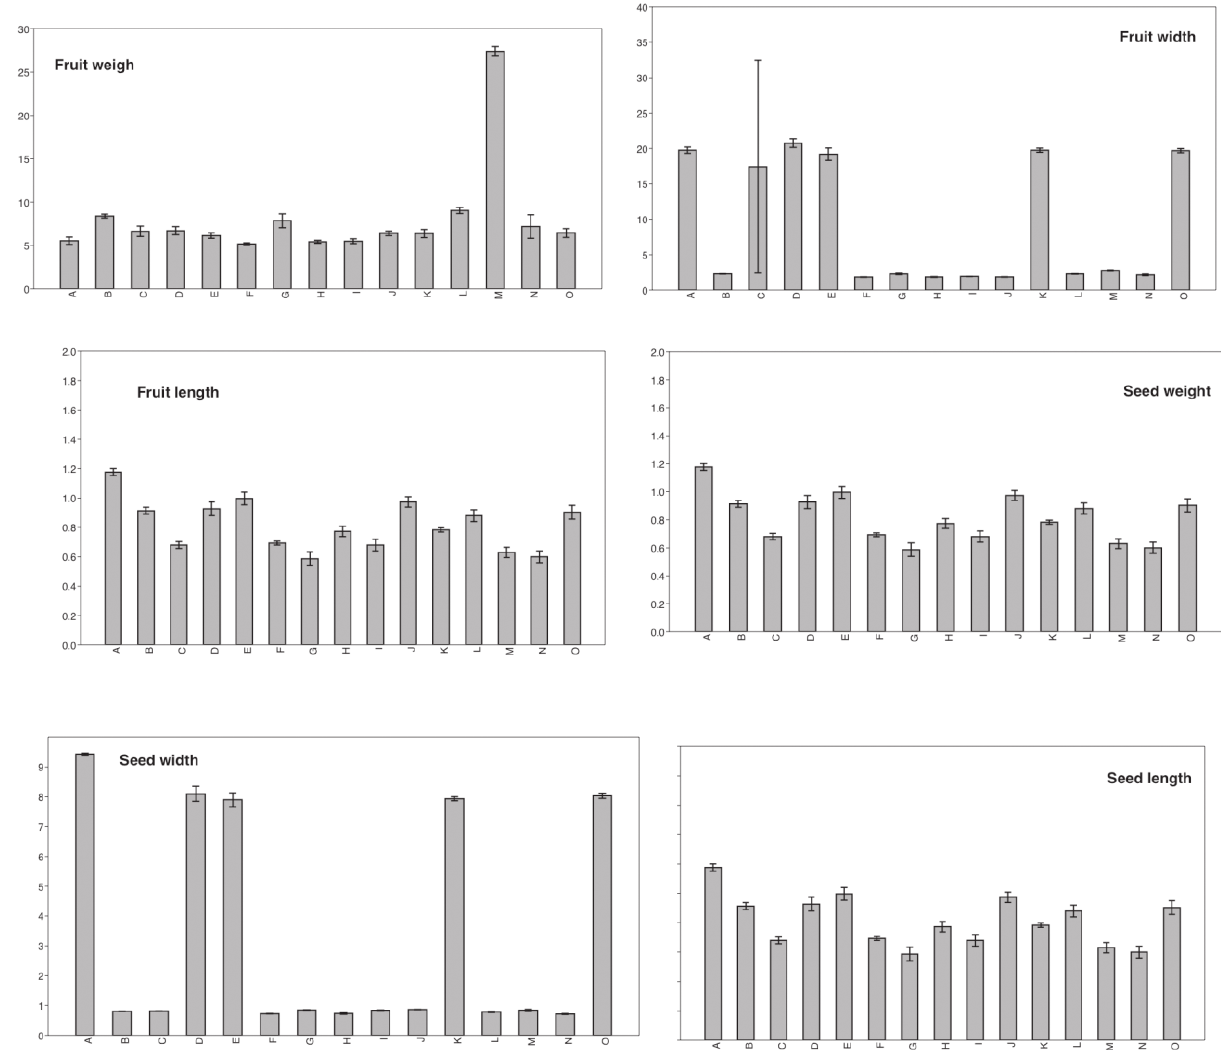
Figure 6. ANOVA of morphological characters studied in date palm variability within date palm cultivar germplasm, which can be used in future breeding program.